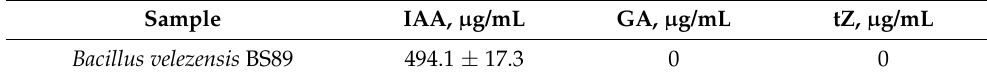
Table 2. The concentrations of IAA, tZ, and GA in the bacterial suspension of Bacillus velezensis BS89. Sample